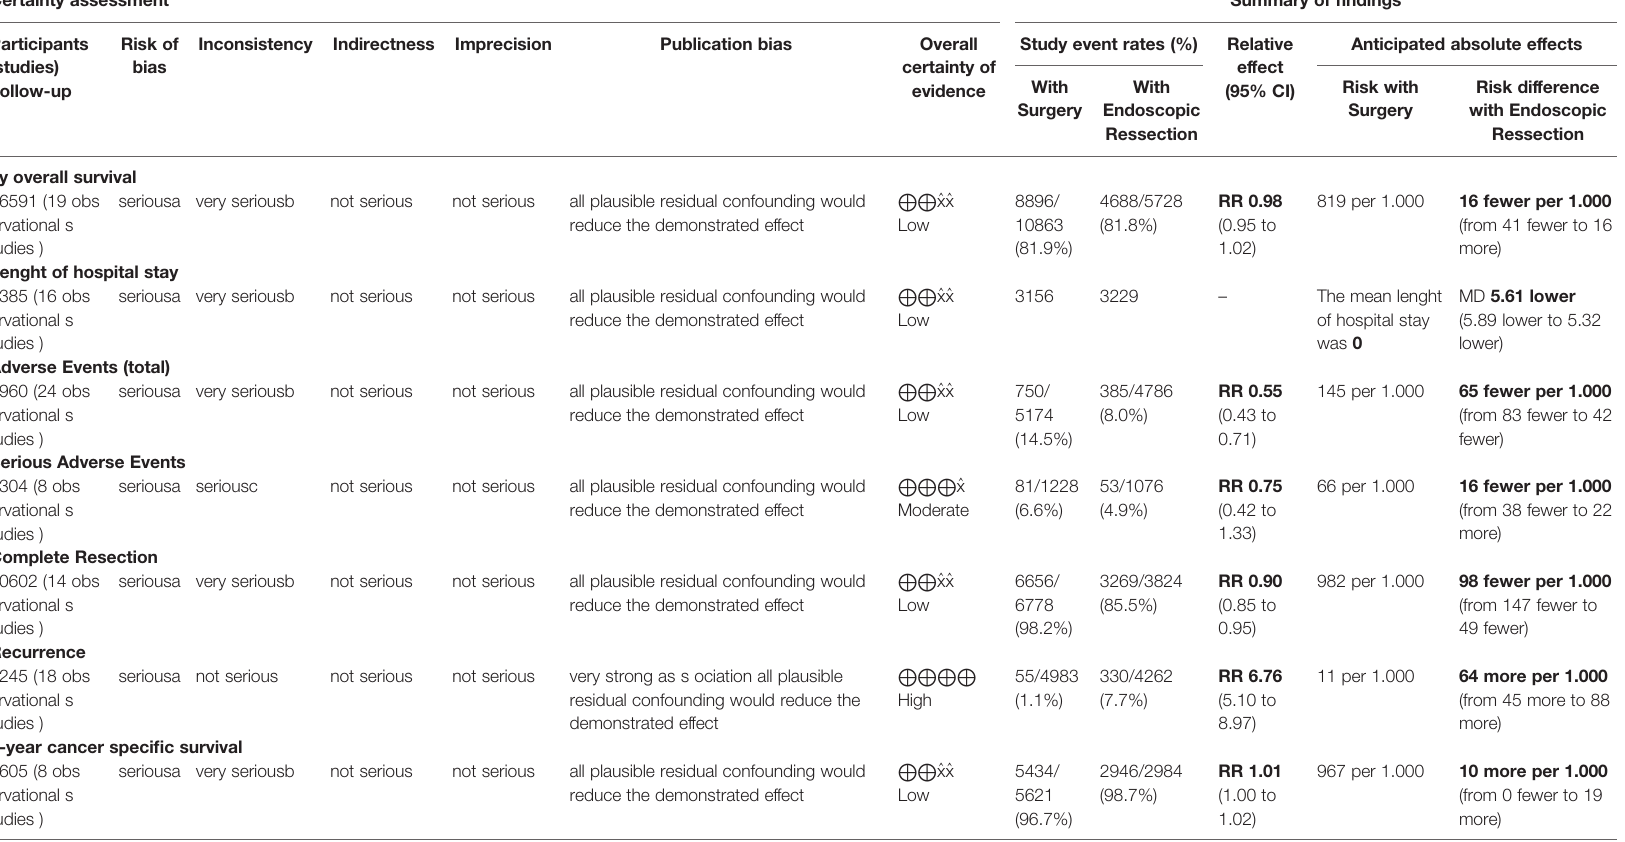
TABLE 3 | Quality of evidence evaluated by